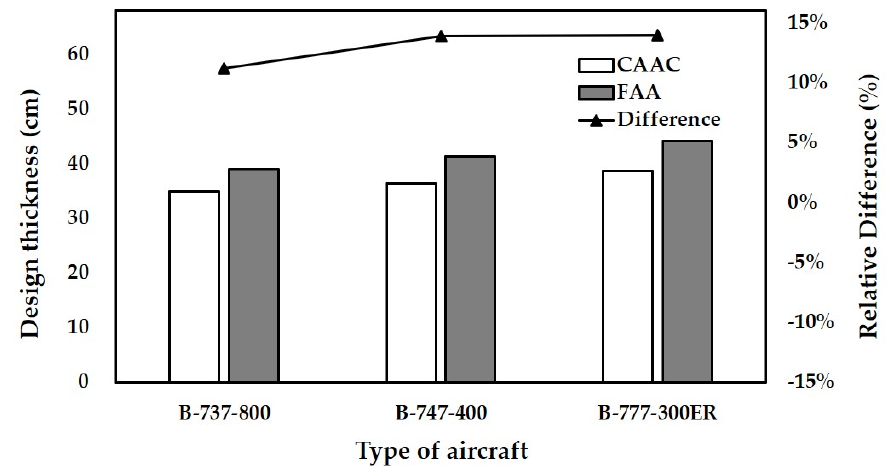
Figure 9. Designed thickness of concrete slabs for different aircraft.